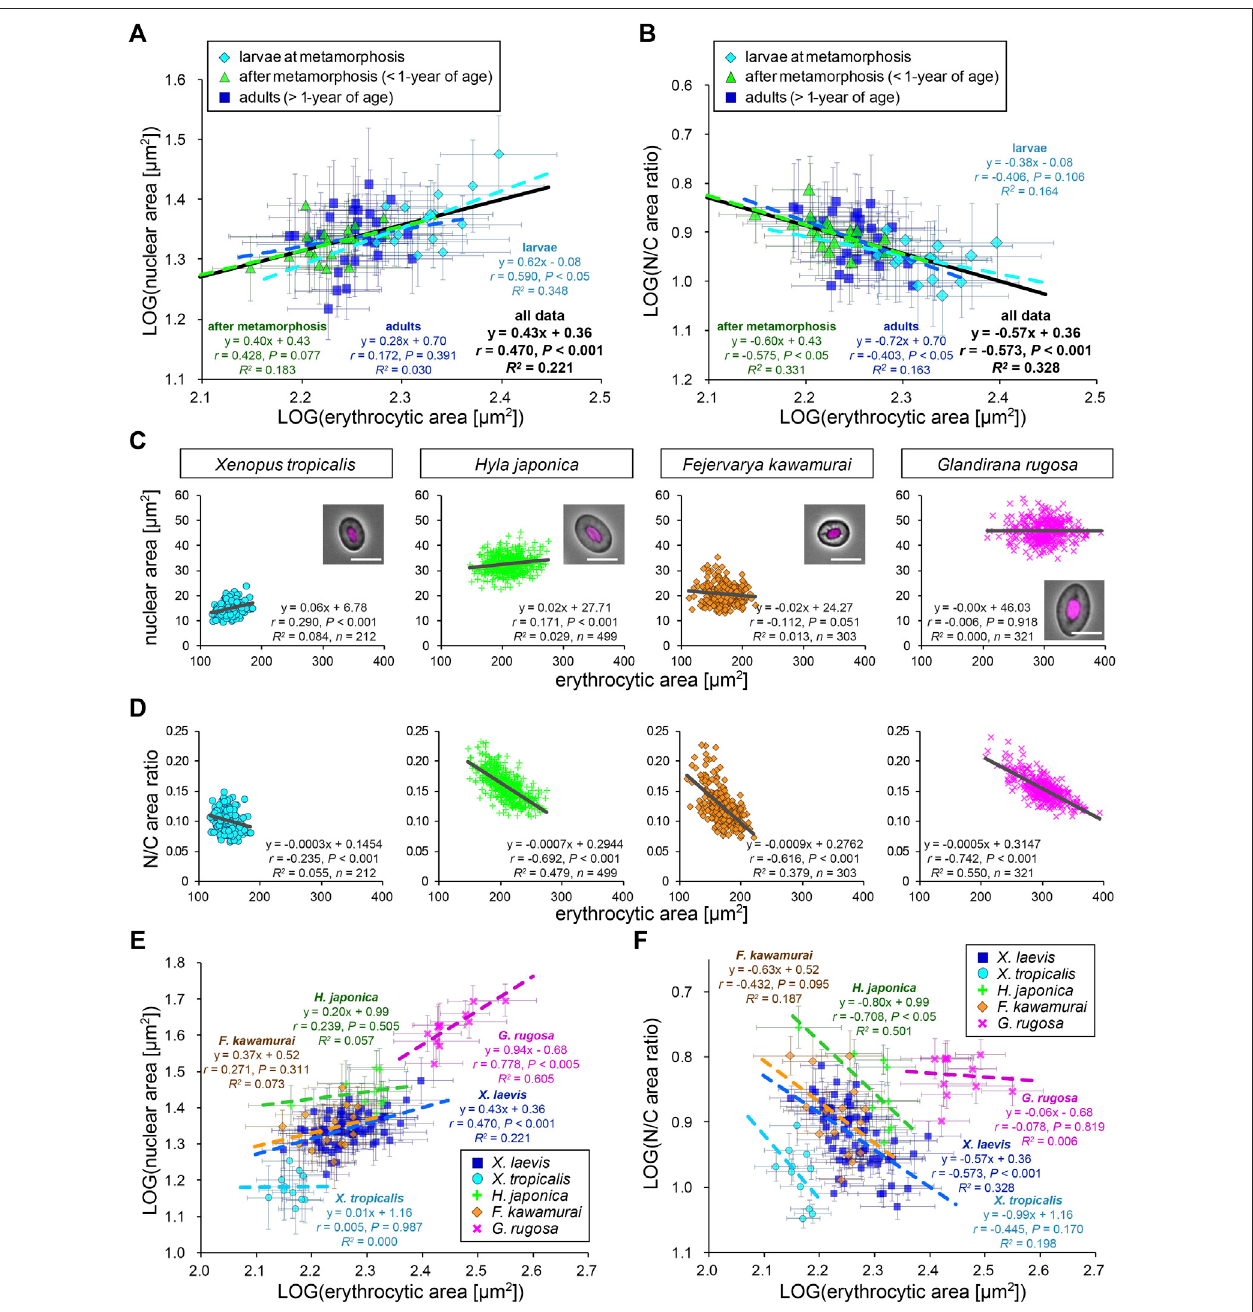
FIGURE2| Comparison ofnuclearcross-sectional areas witherythrocyticareaswithineachfrogspecies. (A) Calculatedmeannuclearcross-sectional areas were plotted against mean erythrocytic cross-sectional area in a log-log plot. Each symbol corresponds to the mean data (±SD) from each X. laevis individual at the stages of larva during metamorphosis (light blue, n = 17), young adult after metamorphosis (green, n = 18), or fully grown adult (blue, n = 27). The equation for the regression line, Pearson ’ scorrelation ( r ), P values, and the coef fi cientofdetermination ( R 2 )have been indicatedat each developmental stage (colored lines) and for theoverall data (black). (B) The calculated mean value of the N/C area ratios were plotted against the mean erythrocytic areain a log-log plot. (C) The measured nuclear cross-sectional areas were plotted against the erythrocytic cross-sectional areas of adult frogs X. tropicalis (light blue), H. japonica (light green), F. kawamurai (orange), and G. rugosa (pink).Wecouldnotjudgetheexactageofthesefrogs,whichwerecaughtinarice fi eld.Eachsymbolcorrespondstothedatafromeacherythrocyte.Amergedimageof an erythrocyte with Hoechst 33342 (magenta) staining and phase contrast is shown in each graph. Scale bar = 10 μ m. The equation for the regression line, sample number( n ), r , P values,and R 2 havebeenindicatedineachplot. (D) ThecalculatedmeanvaluesofN/Carearatioswereplottedagainstthemeasurederythrocyticareas. (E) Thecalculatedmeannuclearcross-sectionalareaswereplottedagainstthemeanerythrocyticcross-sectionalareainalog-logplot.Eachsymbolcorrespondstothe mean data (±SD) from each frog and each species. The equation for the regression line, r , P values, and R 2 have been indicated in each species. X. laevis : n = 62; X.